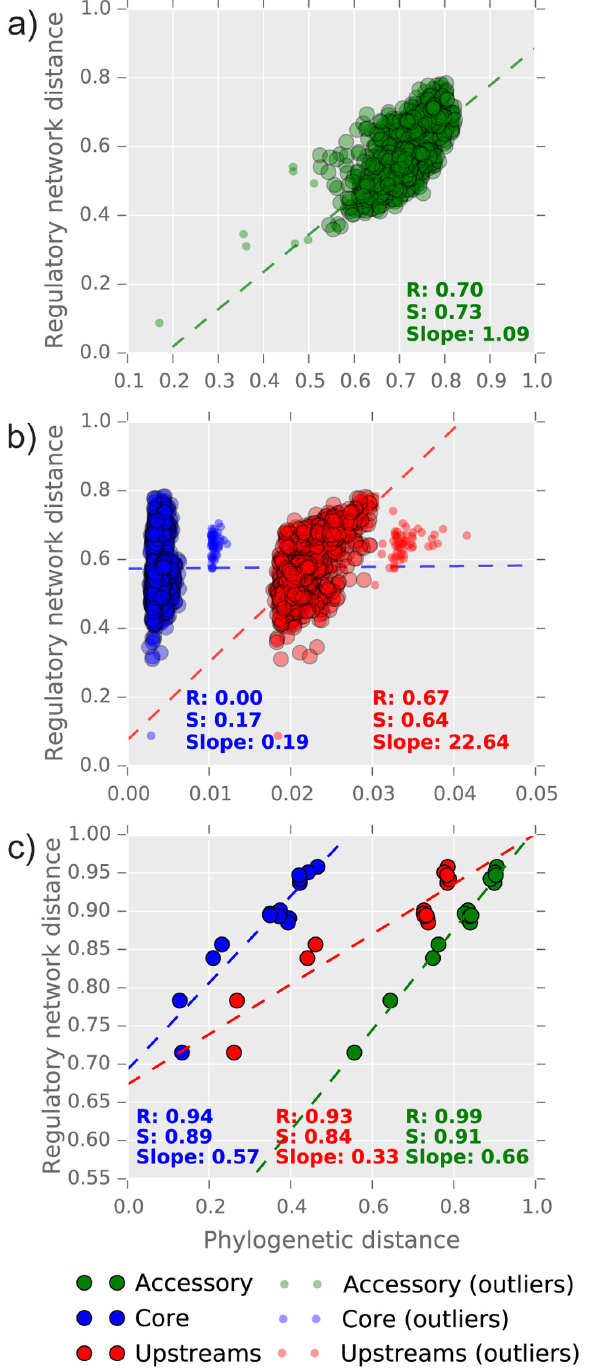
Fig 3. Correlations between pangenome diversity and regulatory network distances. R and S indicate the Pearson ’ s and Spearman ’ s correlation coefficients between the regulatory network and each pangenome partition distances (see Materials and Methods for the definition of the distances metrics used here). Outliers have been defined using a Z-score threshold of 3.5 on the mean absolute deviation of the distances. a) correlations within the S. meliloti species for the accessory genome; b) correlations within the S. meliloti species for coding and upstream regions; and c) correlation between the